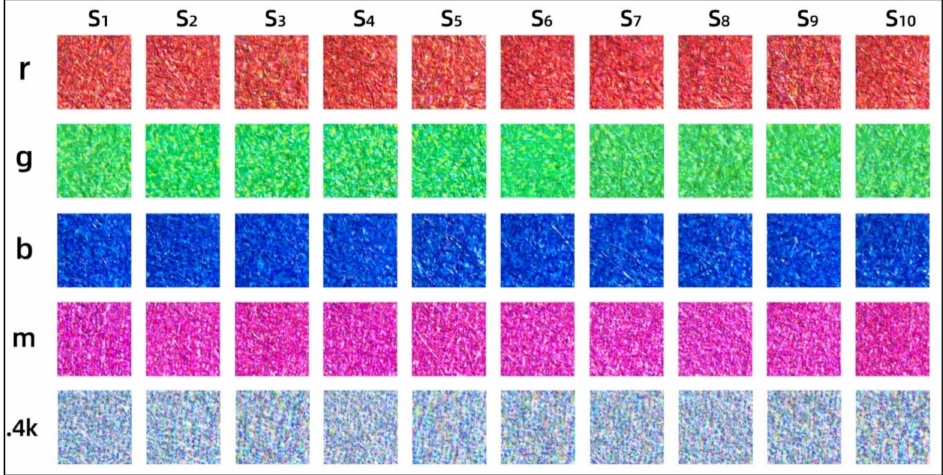
Figure 7. The microscopic images of the same surface sampling on each